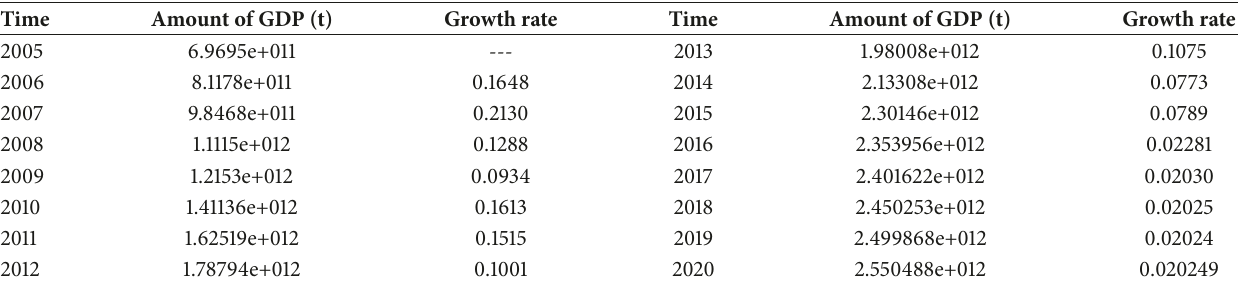
Table 6: Amount of GDP and its growth